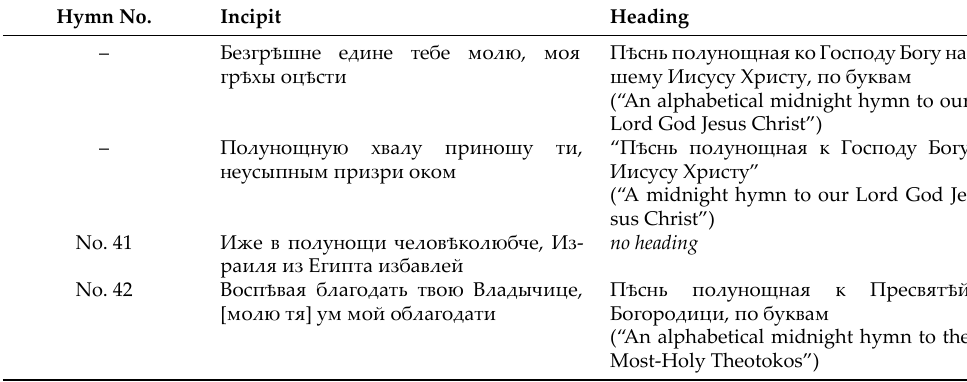
Table 7. The kata stichon hymns in Moscow, GIM MS Muzeisk. 347. Hymn